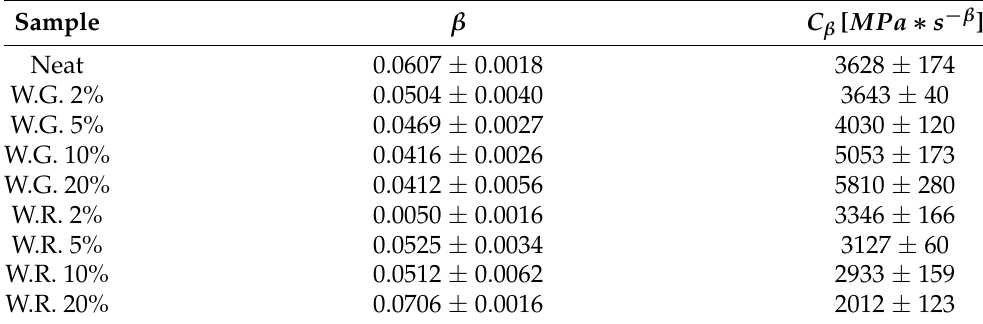
Table 2. Stress relaxation results.